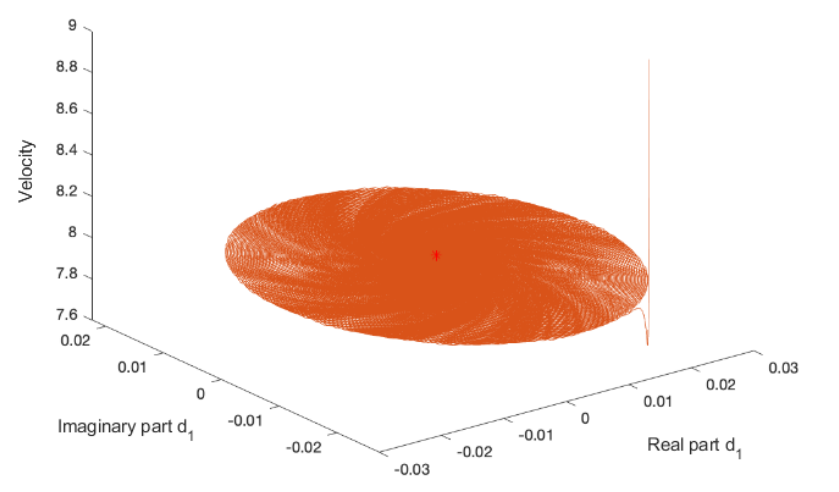
Figure 2. Concentration–velocity phase diagram ( Real ( d ) , Im ( d ) , v ) for a Reynold’s number of 10.